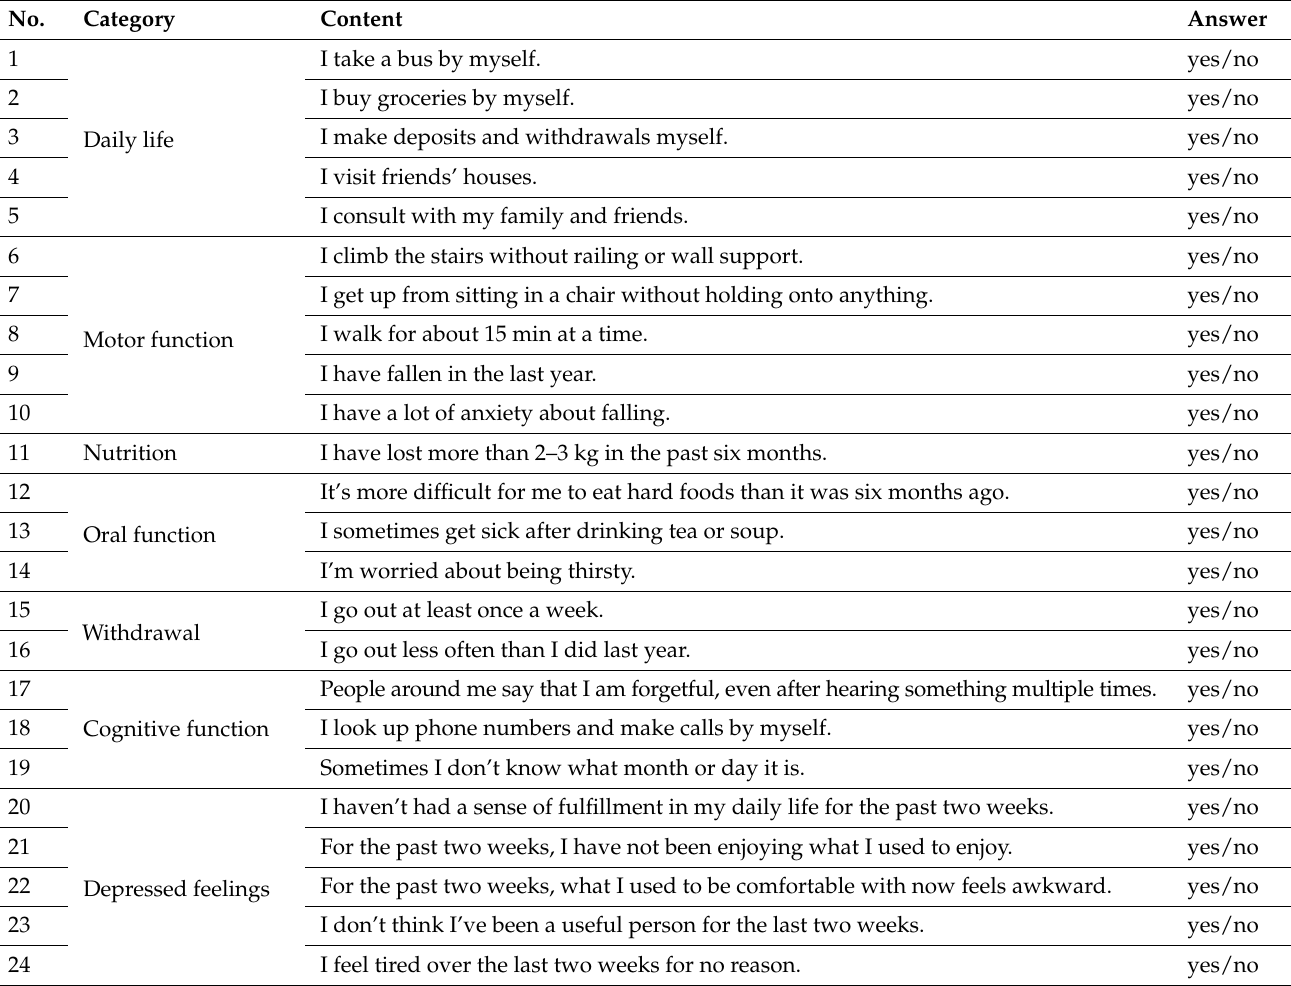
Table 1. Content of the Kihon